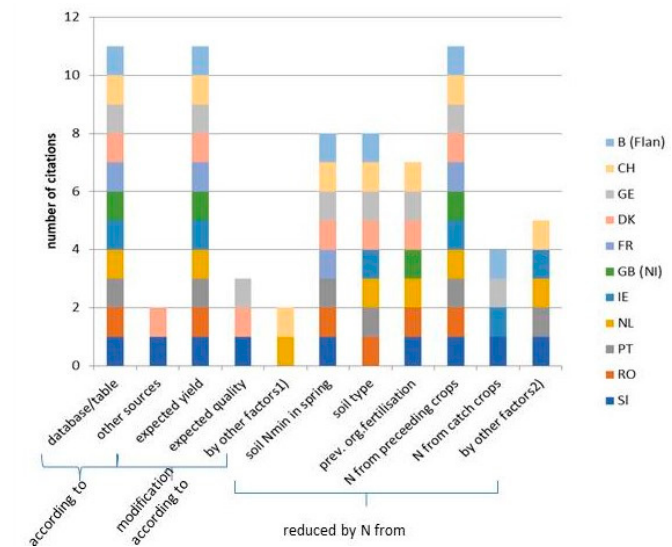
Figure 4. Factors of fertilization planning at the farm level in different member states and Switzerland; (1) NL: grazing or cutting; CH: variety (e.g., for potatoes); DK: soil type and irrigation; (2) PT: N available in irrigation water; IE: nitrogen index. Source: expert survey results.